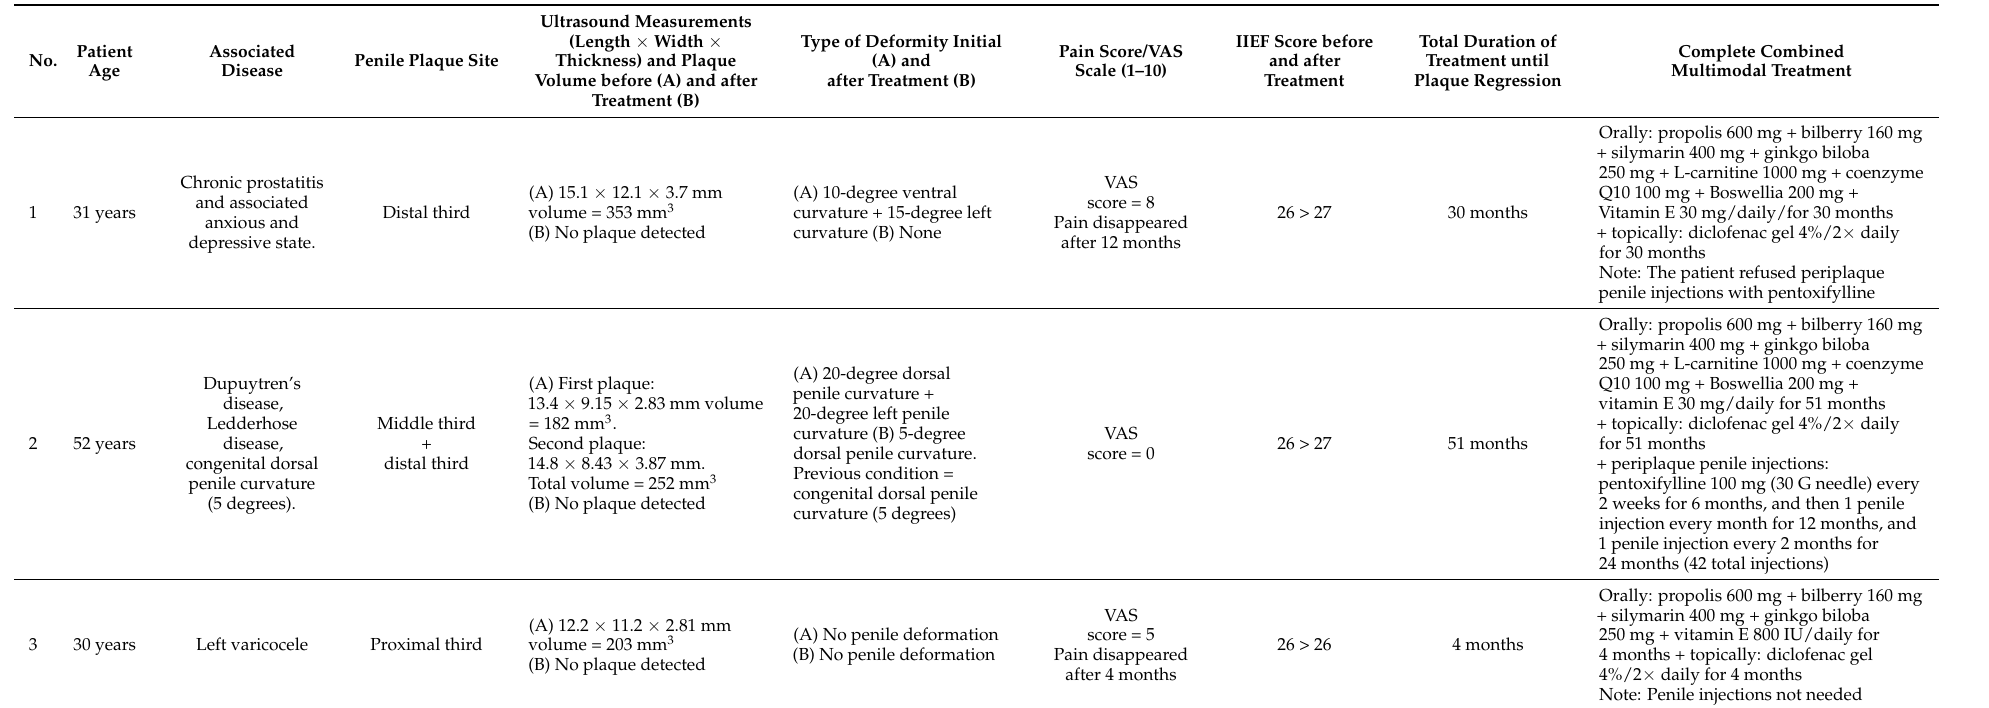
Table 1. Case summaries of three patients with Peyronie’s disease treated with combined multimodal